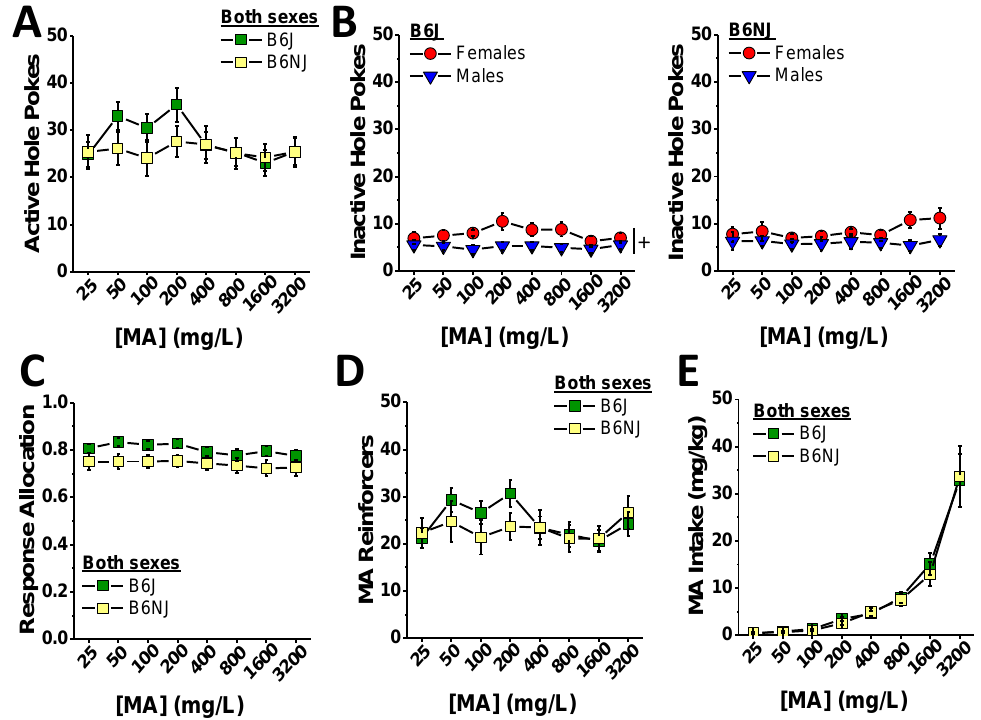
Figure 3. Summary of the substrain and sex differences in MA reinforcement during the dose–response phase of the study, highlighting the small or no group difference in the number of nose pokes into the active, MA-reinforced, hole ( A ) and the inactive, non-reinforced hole ( B ) in B6J (left) and B6NJ mice (right) as well as the response allocation ( C ), the number of reinforcers earned ( D ), and the MA intake ( E ) over a ~100-fold range in MA reinforcer concentrations. The data represent the mean ± SEM of 12 mice/sex/substrain. + represents a significant sex effect, p < 0.05. The pattern of group differences in the number of reinforcers earned during the MA dose–response phase of the study was similar to that observed for active hole responding (Figure 3D vs. Figure 3A) (substrain × concentration: F (7,280) = 2.76, p = 0.009; sex effect and interactions, all p ’s > 0.06) with no statistically significant substrain differences detected at any of the MA reinforcer concentrations ( t -tests, α = 0.00625, all p ’s > 0.10). As the number of reinforcers earned was relatively stable across the different MA concentrations (Figure 3D), MA intake increased progressively and steeply with increasing reinforcer concentration (Figure 3E) (concentration effect: F (7,1280) = 57.41, p < 0.0001). Consistent with the very modest substrain difference in the number of MA reinforcers earned, we detected no statistically significant substrain or sex differences in the dose–response function for MA intake (Figure 3E) (substrain × sex × concentration ANOVA, other p ’s > 0.16).